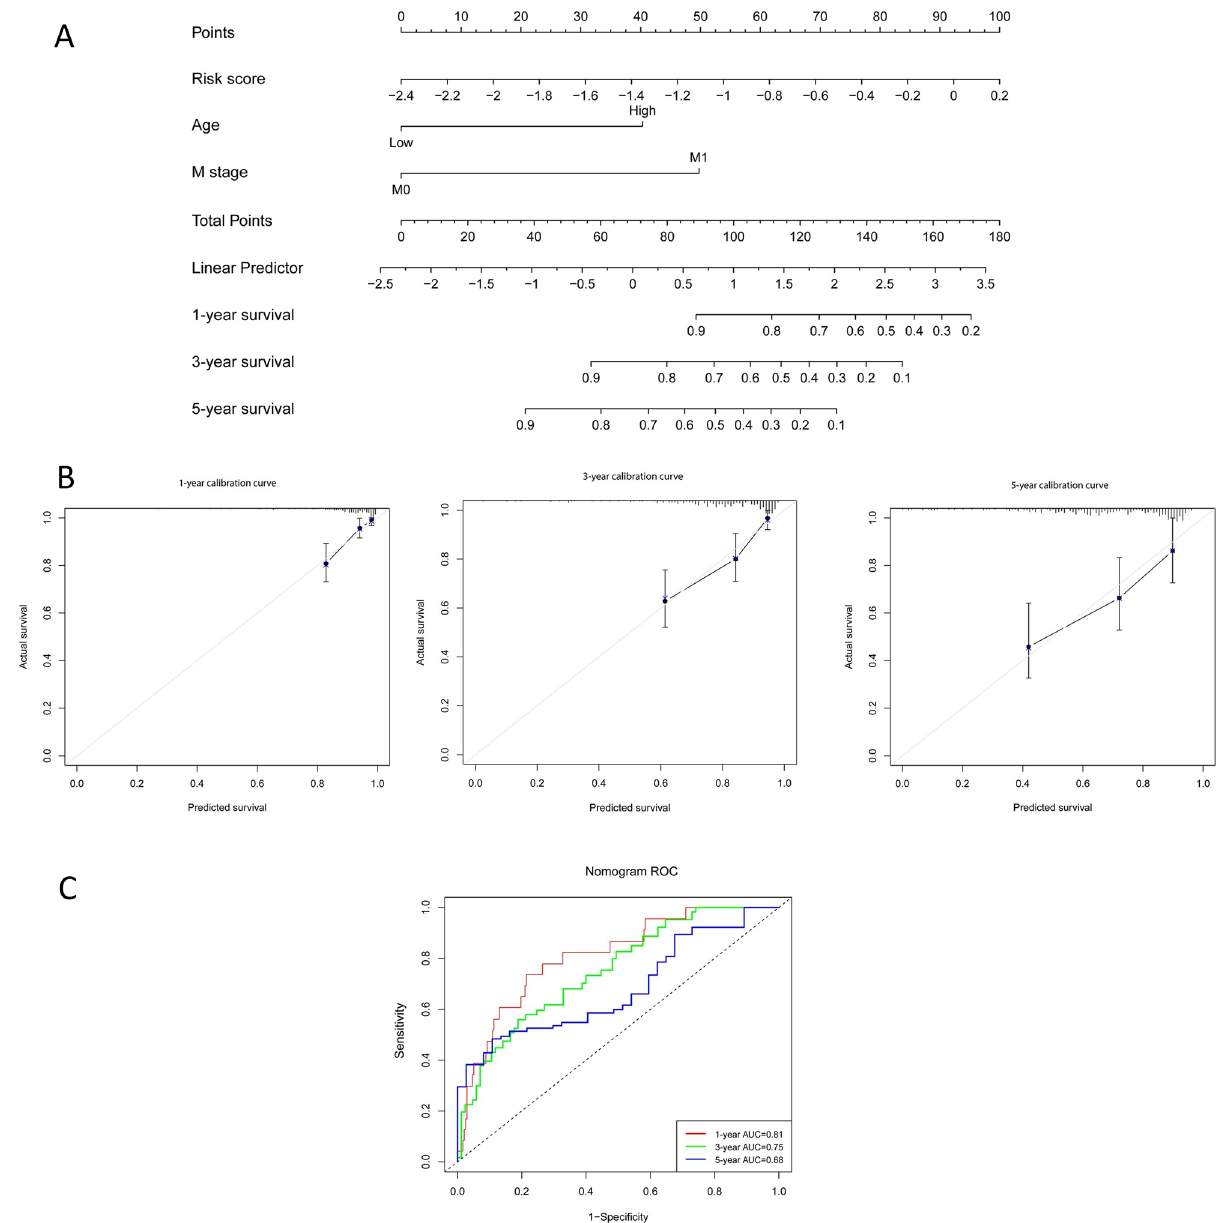
Nomogram in TCGA cohort. ( C ) Time dependent ROC curve analysis of the